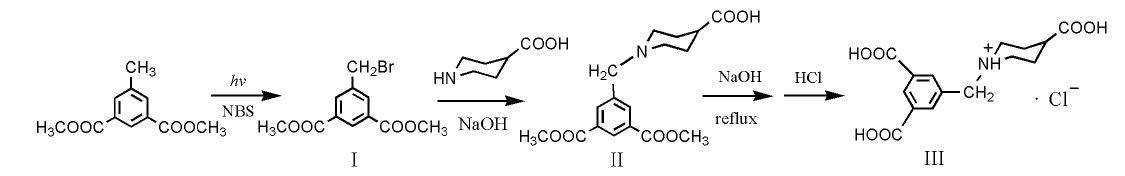
Figure 8. H 2 O adsorption isotherm at 298 K for 1′ : filled shape, adsorption; open shape,